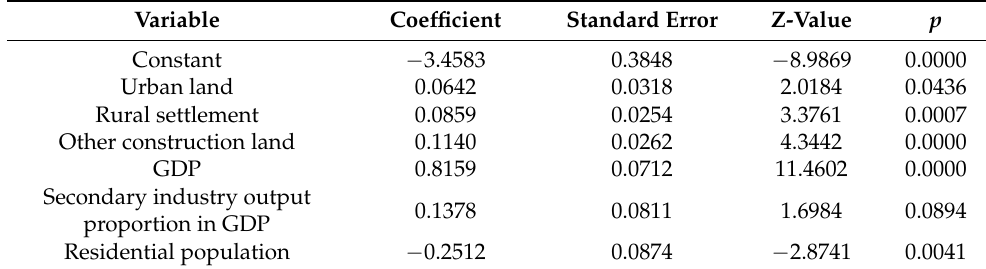
Table 4. SEM model